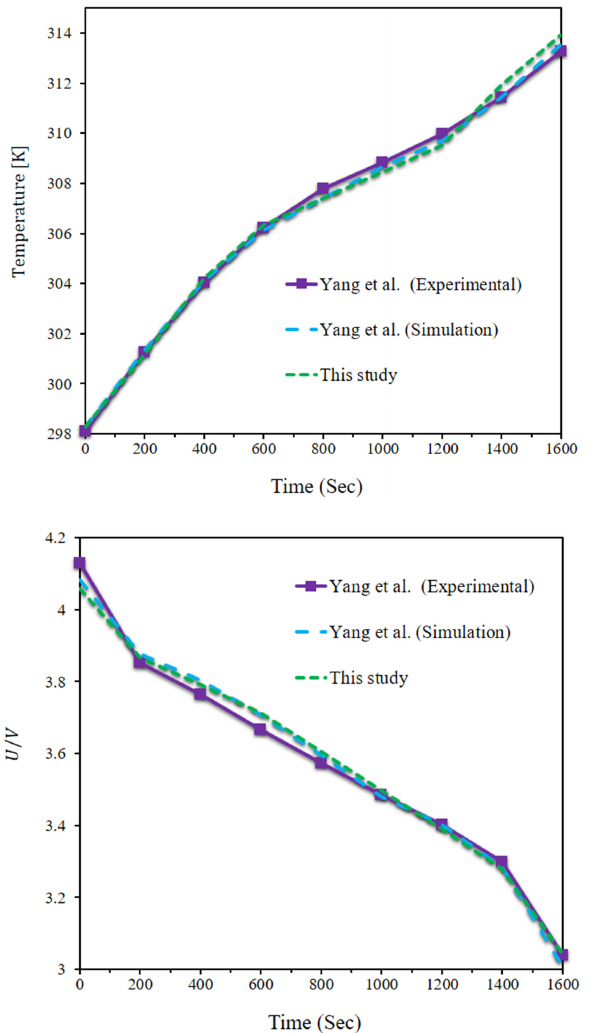
Figure 3. Comparing the results obtained from the present simulations with those reported by Yang et al.